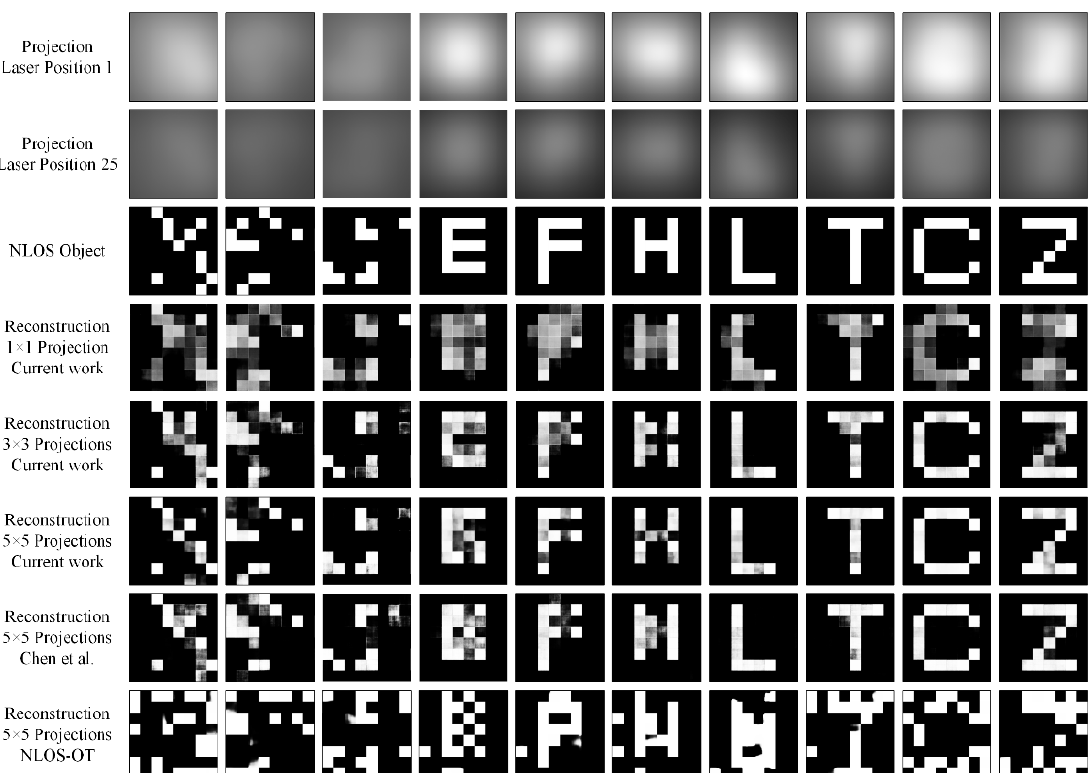
Figure 5. Comparison of the reconstruction results on the simulated data.